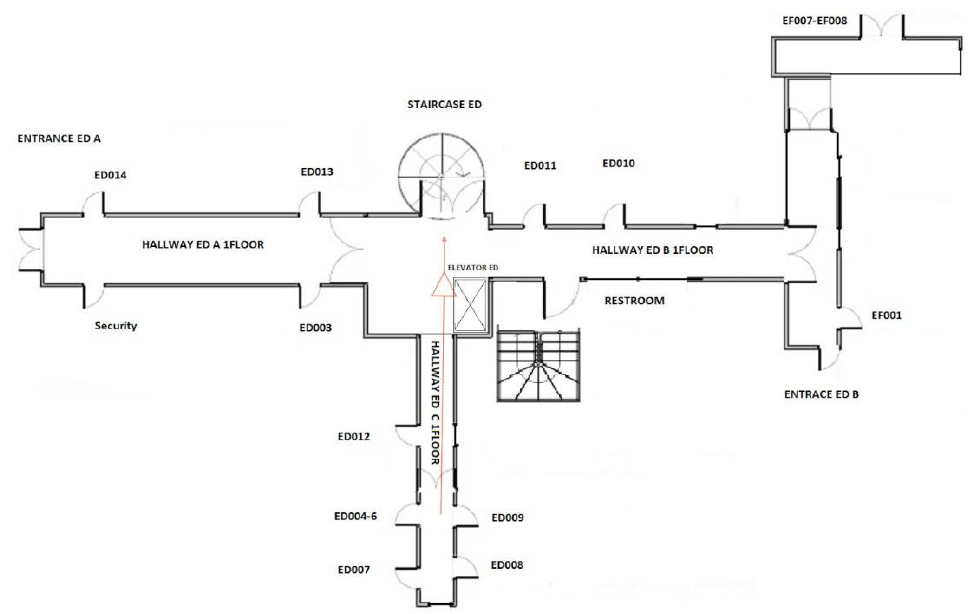
Figure 9. Example of graphical routing directions provided by the user interface .